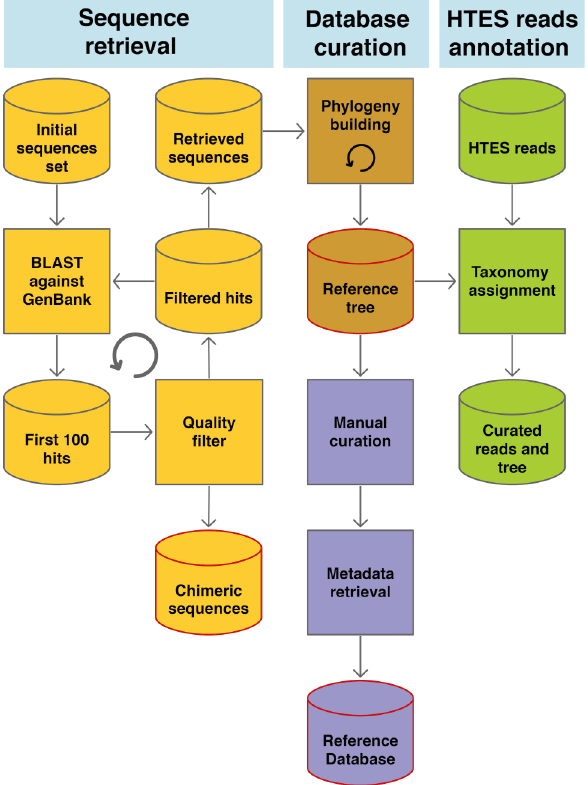
Fig 2. Simplified scheme of the EukRef workflow. Outputs are highlighted in red. HTES, high-throughput environmental sequencing.